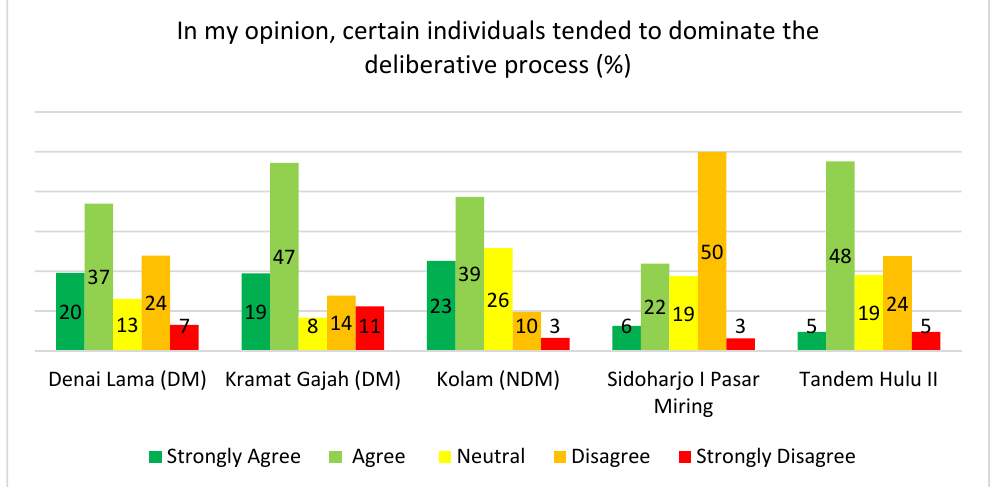
Figure 9. Domination of the Musrenbang deliberations by certain participants.